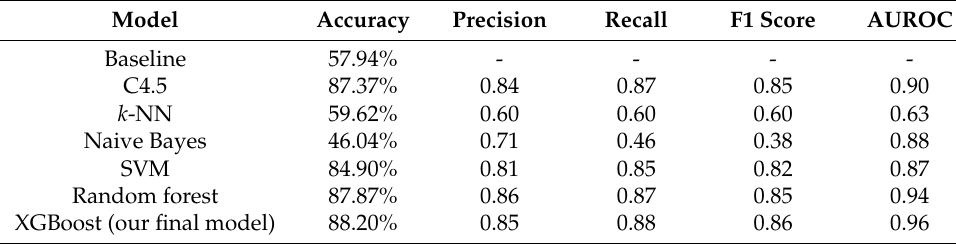
Table 5. Prediction performance of various machine learning models.